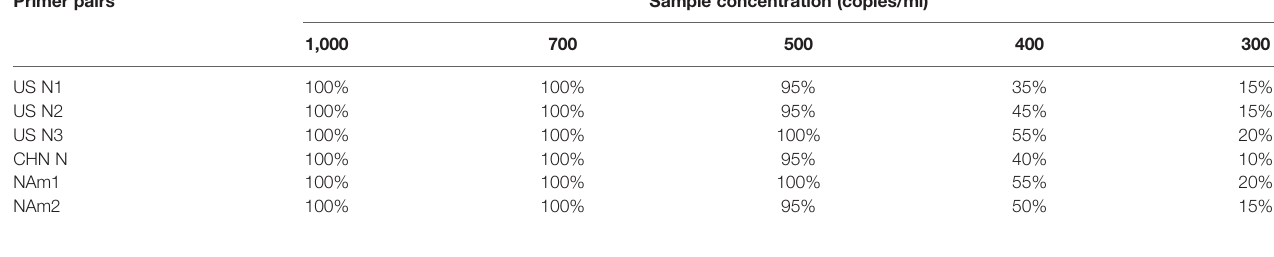
TABLE 2 | Positive rate for primer pairs at different concentrations. Primer pairs